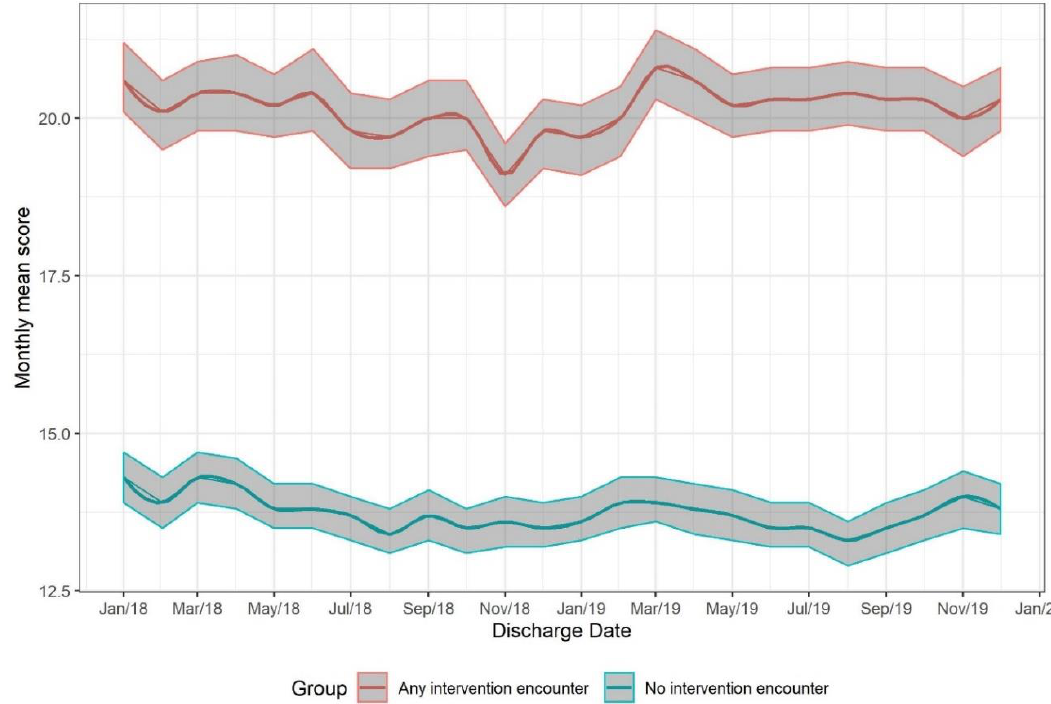
Figure 5. Mean risk score (with 95% CI) over time by whether intervention was received or not.